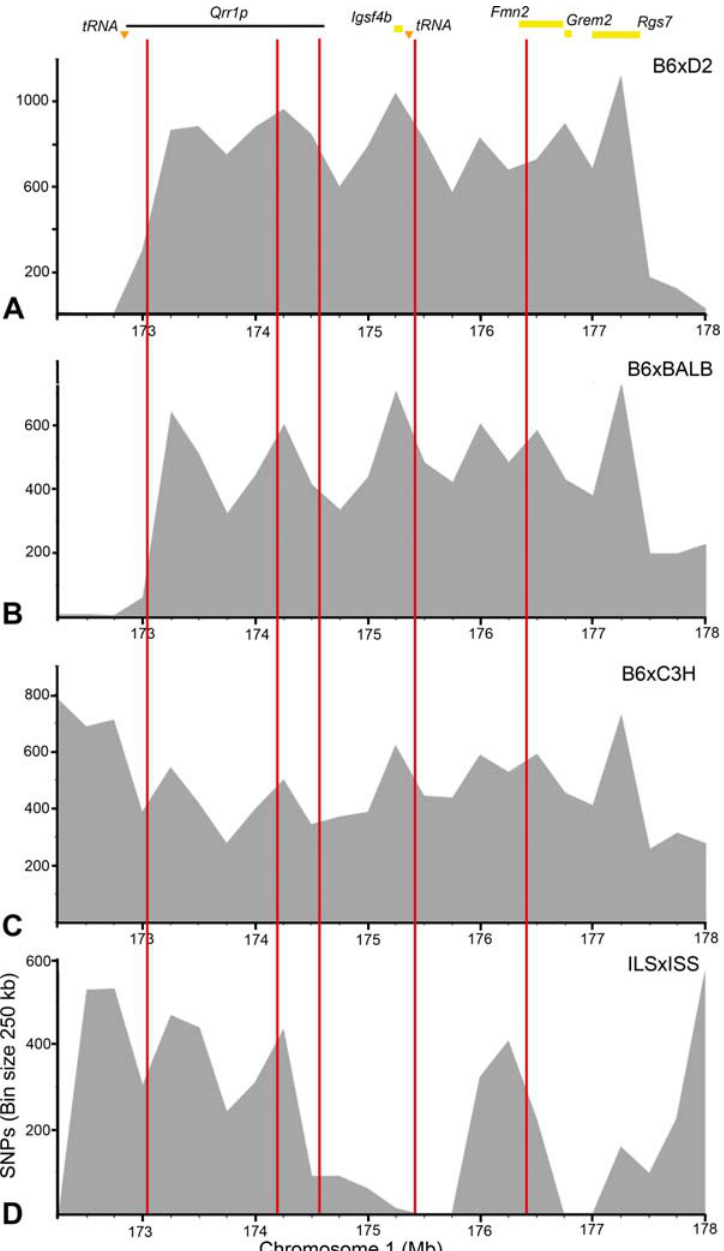
Figure 6. SNP comparison between crosses. SNPs in Qrr1 were counted for (A) C57BL/6J (B6) 6 DBA/2J (D2), (B) B6 6 BALB/cBy (BALB), (C) B6 6 C3H/HeJ (C3H), and (D) ILS 6 ISS. The SNP distribution profiles were generated by plotting the number of SNPs in 250 kb bins. Vertical red lines mark the approximate positions of recombination (corresponds to figure 2). Region covered by Qrr1p (horizontal line), candidate genes in Qrr1d (yellow bars), and position of tRNA clusters (triangles) are shown above the graphs. The B6 6 D2, B6 6 BALB, and B6 6 C3H crosses have moderate to high SNP counts throughout Qrr1 . In the ILSxISS cross, Qrr1p is relatively SNP-rich but Qrr1d is SNP-sparse.